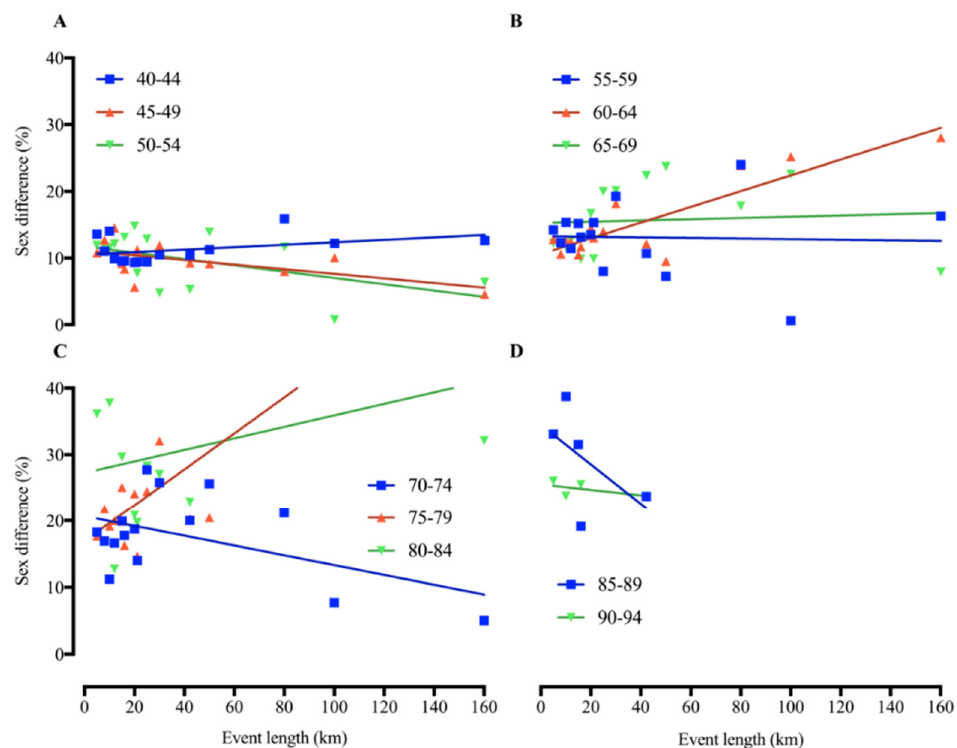
Figure 3. Linear regression between performance sex difference (%) and event length (km) in America masters road running records. ( A ) Age groups from 40 to 54 years old; ( B ) 55 to 69 years old; ( C ) 70 to 84 years old; ( D ) 85 to 94 years old.